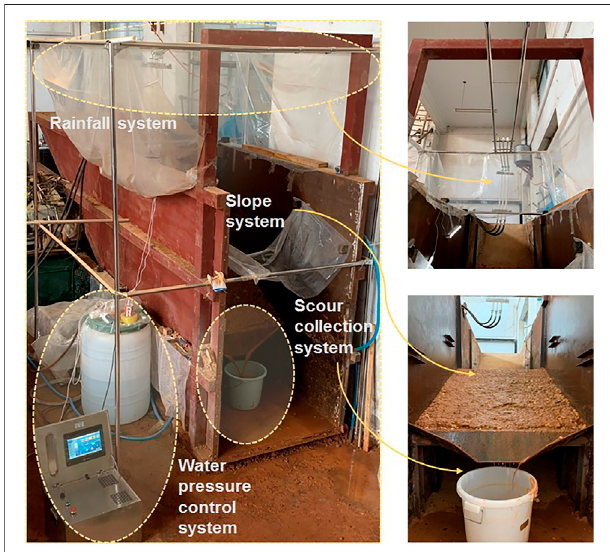
FIGURE 7 | Arti fi cial rainfall-slope erosion model test device.